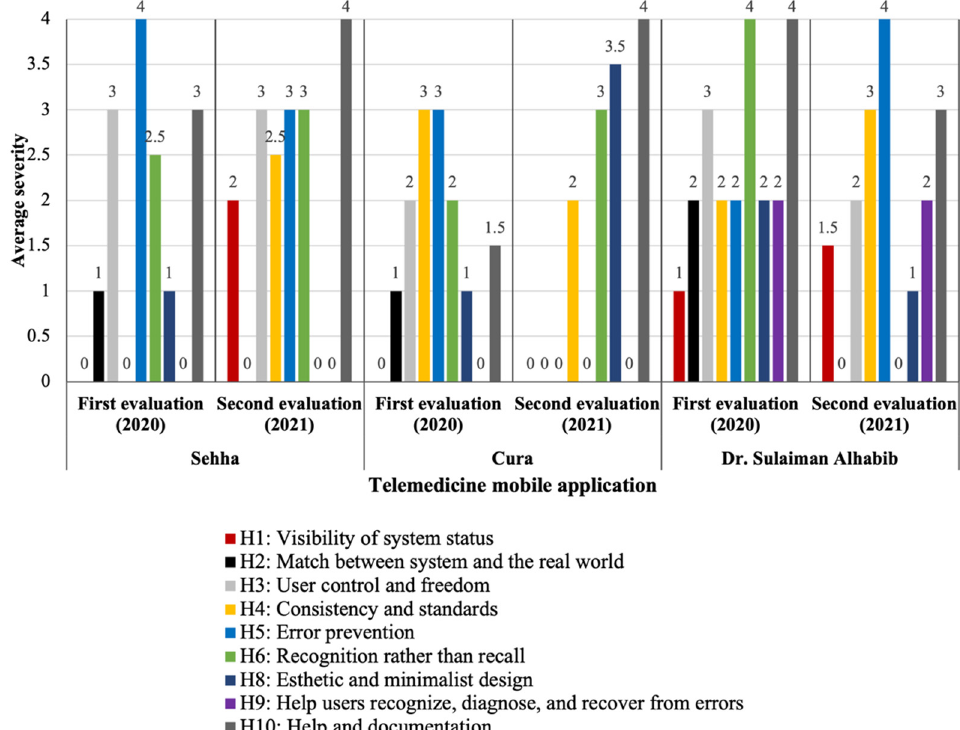
Figure 2. Average severity ratings by heuristic items among the three apps. H7: Flexibility and efficiency of use is not displayed in the chart.